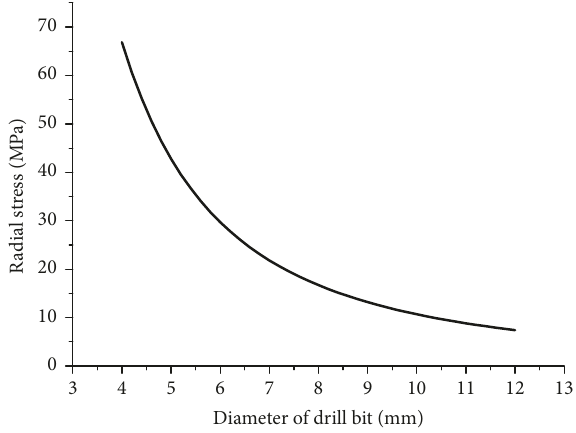
Figure 11: Relation curve between radial stress and drill bit diameter.